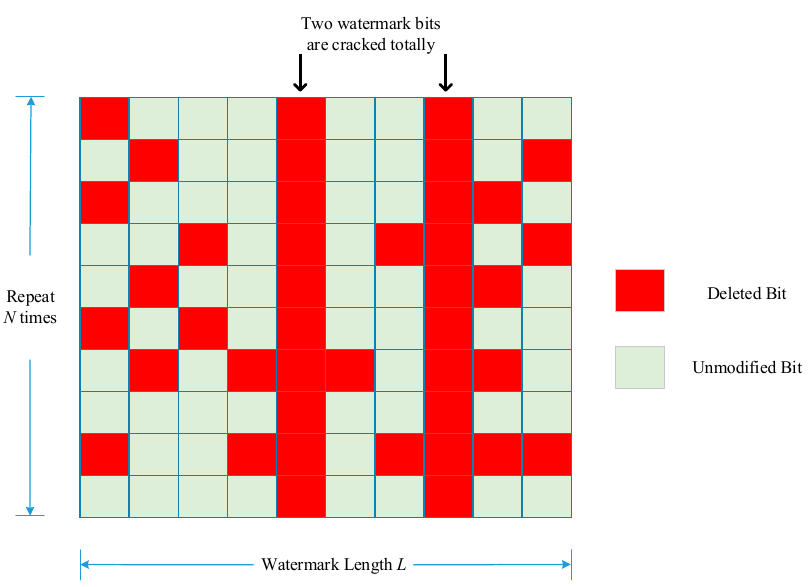
Figure 8. An example does not belong to enumerations of function P .